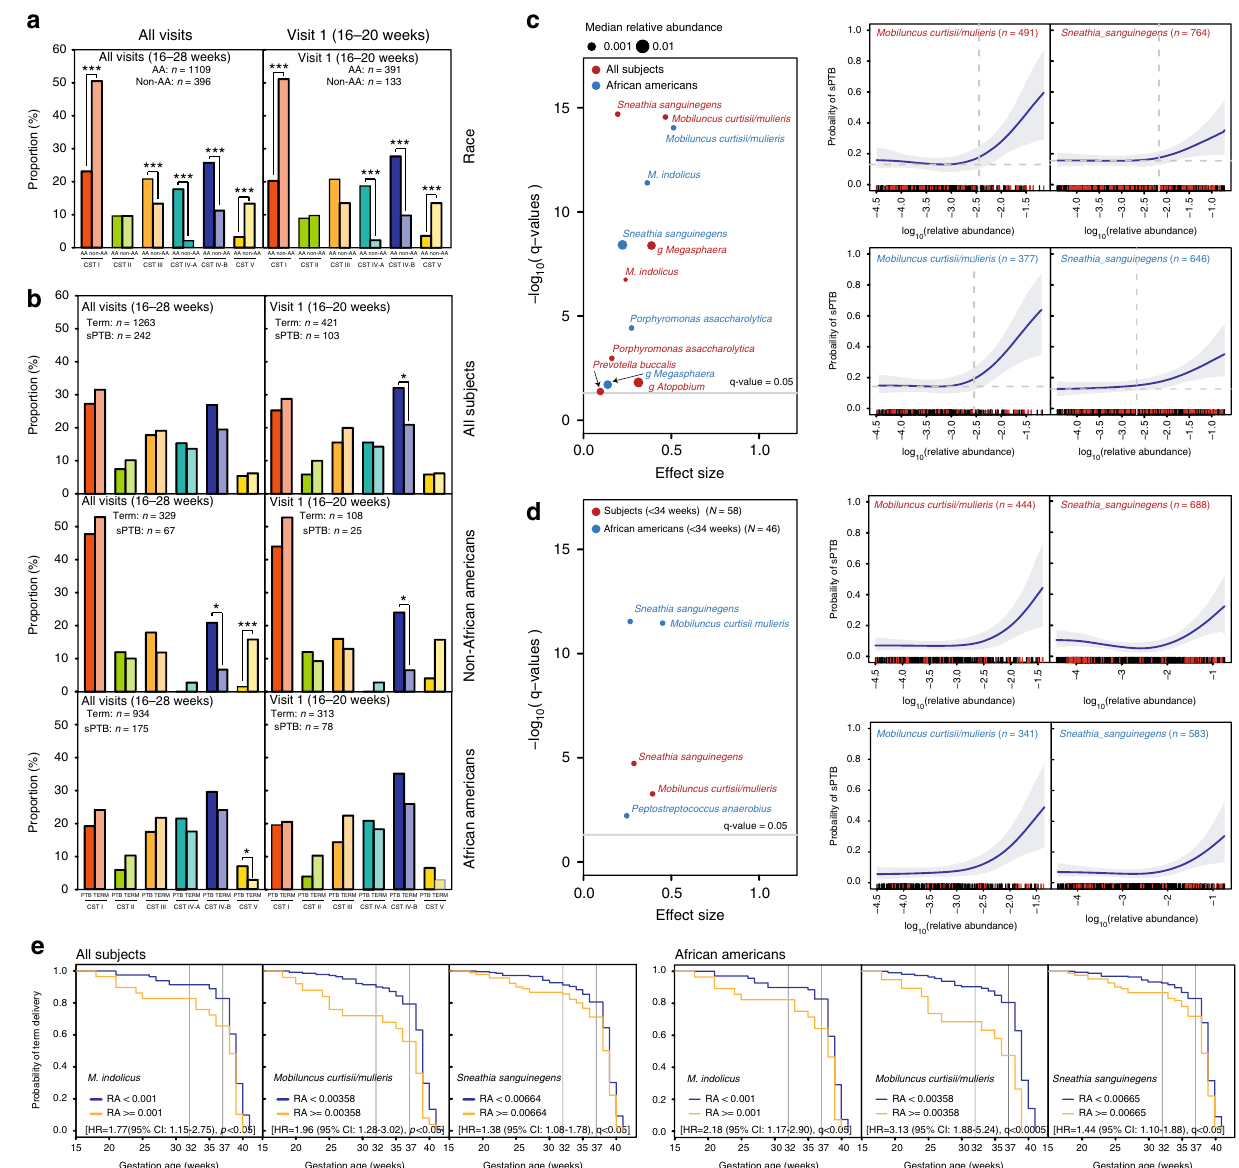
Fig. 1 Vaginal microbiota composition and structure and risk of sPTB. a Frequency of each CST in non-AA and AA pregnant women when considering samples collected at all three visits or visit 1 (16 – 20 weeks of gestation). b Frequency of each CST strati fi ed by outcomes (sPTB vs term) in all subjects, non-AA and AA when considering samples collected at all three visits or visit 1 alone. n represents the number of samples included in the analysis. For ( a ) and ( b ) p -values were estimated using mixed effects Poisson regression models (all visits) or ordinary logistic regression models (single visit) ( c ) Volcano plot for seven bacterial taxa statistically signi fi cantly associated with increased risk of sPTB in all subjects (red) and AA (blue) showing the effect size on the x -axis and the strength of the association on the y -axis. The gray horizontal lines indicate q -value of 0.05. The median relative abundance of each phylotype is indicated by the size of the point. Dependence of the risk of sPTB (de fi ned as <37 weeks of gestation) on the log 10 relative abundance of M. curtisii/mulieris and S. sanguinegens in all subjects and AA is shown on the right. Effect size is the difference between the lowest and highest probability of sPTB. Greyed area indicates 95% credible region. Dotted line corresponds to the signi fi cant risk of sPTB threshold values (taxa log 10 relative abundance above which the risk is signi fi cant different from baseline). n represents the number of samples in which the bacterial taxon was detected and included in the analysis. ( d ) is the same as ( c ) but with sPTB de fi ned as birth at <34 weeks of gestation. N represents the number of subjects in each group. Statistically signi fi cant taxa were identi fi ed using a Bayesian logistic regression nonparametric adaptive spline models. e Kaplan – Meier survival plot for M. indolicus , M. curtisii/mulieris and S. sanguinegens in all and AA women who harbor these bacterial taxa at relative abundance (RA) below (blue) or above (orange) the threshold values above which the risk of sPTB is signi fi cant different from baseline. p -values estimated using Cox proportional hazard regression models using coxph() routine of the survival R package. Statistical signi fi cance is shown as * p -value < 0.01, ** p -value < 0.001, and *** p -value <